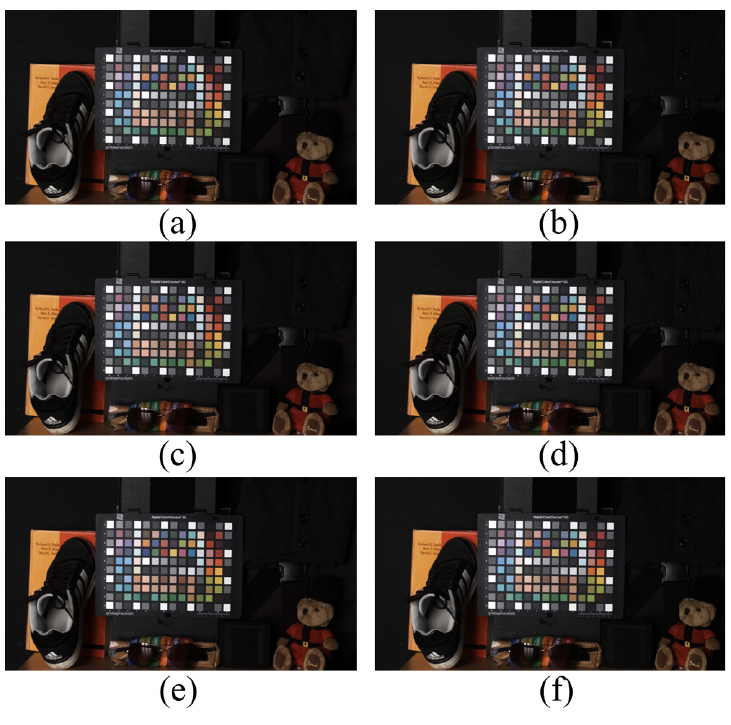
Figure 17. Experimental results under a fluorescent lamp (350 lx). ( a ) Input image; ( b ) optical filtered visible band image; ( c ) 3 × 3 CCM; ( d ) 3 × 4 CCM; ( e ) root-polynomial mapping; ( f ) proposed method.